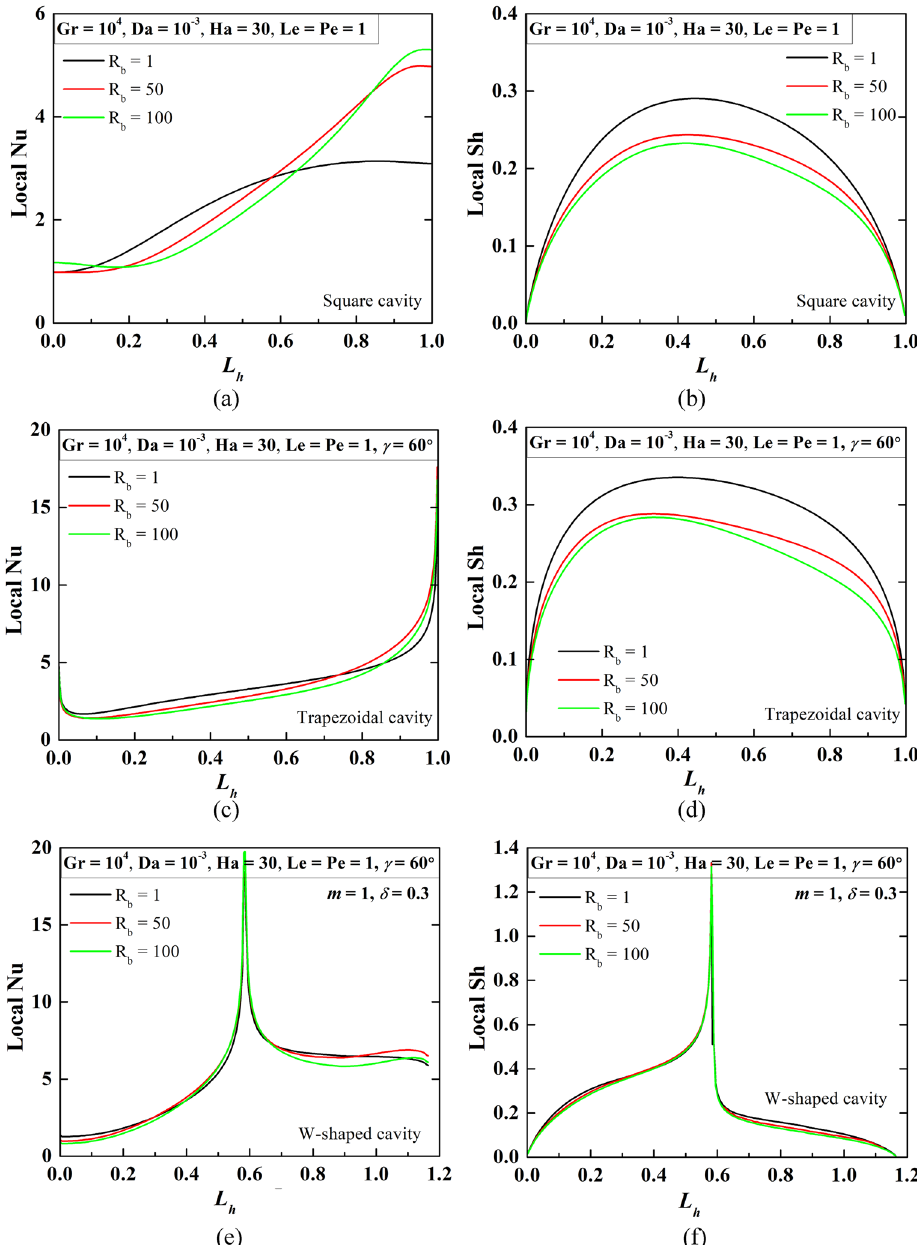
Figure 7. Patterns of local Nu and Sh (over the heated wall) for R b = 1, 50, 100 at Le = Pe = 1, Gr = 10 4 , Da = 10 –3 , Ha = 30 for square ( a , b ), trapezoidal ( c , d ), and W-shaped (e–f)